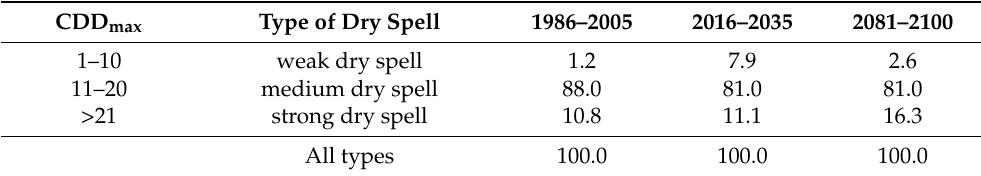
Table 3. The proportion of the three types of dry spells (%) defined from the CDD max values in the 22 Hungarian wine regions in the three investigated periods, i.e., recent past (1986–2005), near future (2016–2035), and distant future (2081–2100). The categories and their limits in the second column of the table are defined by [19].